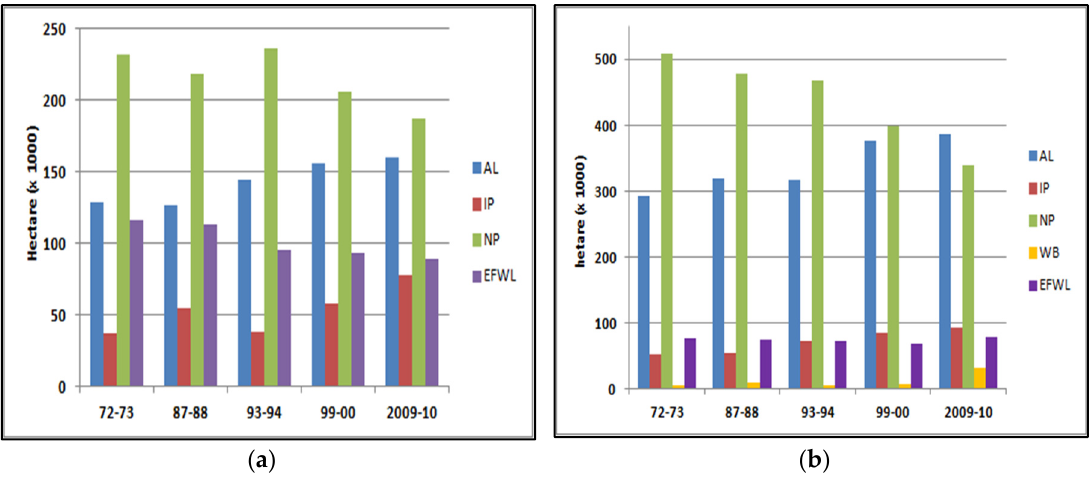
Figure 8. Land cover from 1972–1973 to 2009–2010 in the ( a ) Liverpool Range; and ( b ) Liverpool Plains provinces.